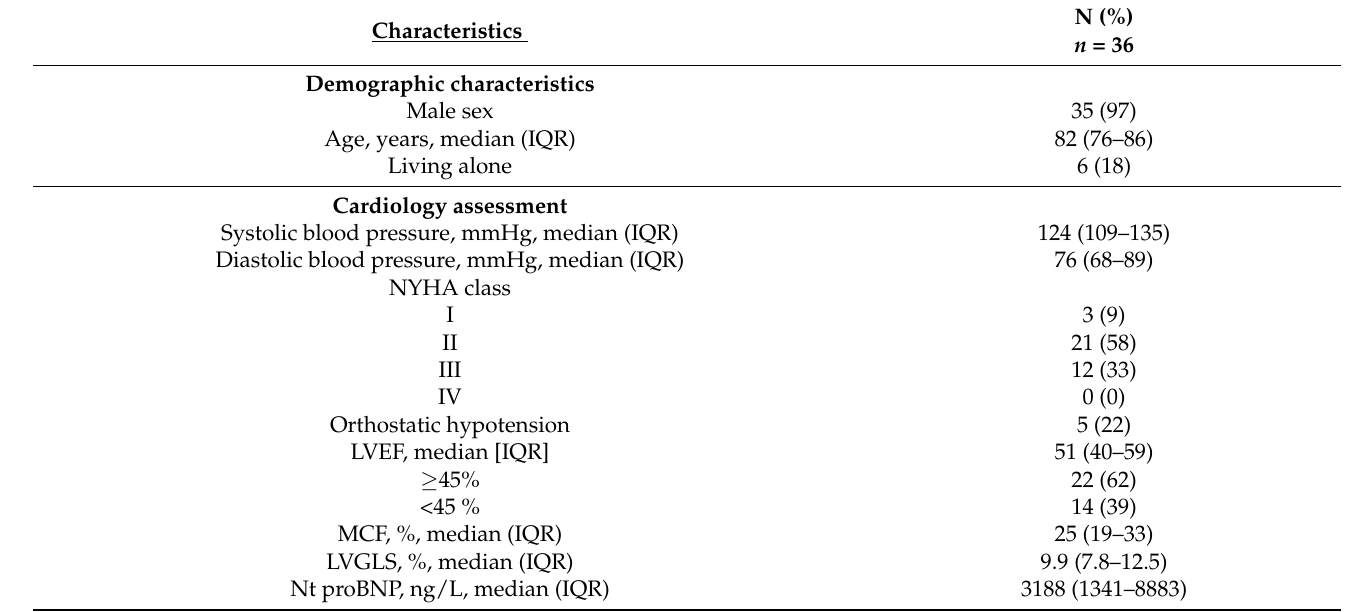
Figure 1. Study flowchart. Consecutive patients with ATTRwt-CA consulting at the French National Reference Center for Cardiac Amyloidosis having agreed to undergo a multidimensional geriatric wild-type transthyretin cardiac amyloidosis. Table 1. Characteristics of the patients with